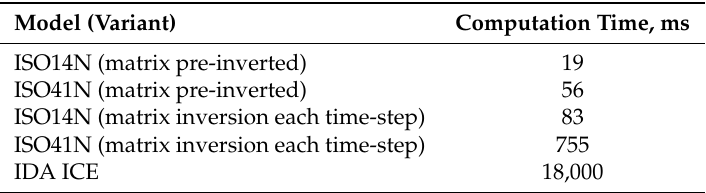
Table 8. Computation benchmark, timing in